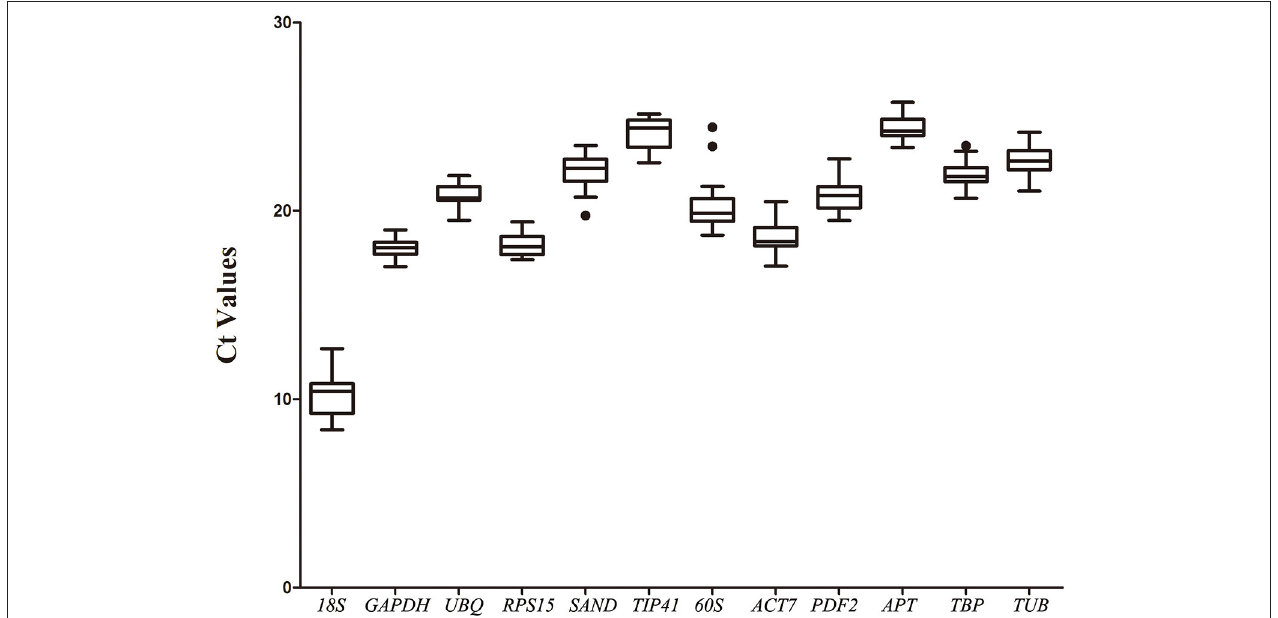
FIGURE 1 | Expression levels of 12 candidate reference genes across all experimental samples. The box graph indicates the interquartile range, the median, and maximum/minimum values. Dots indicate outliers.